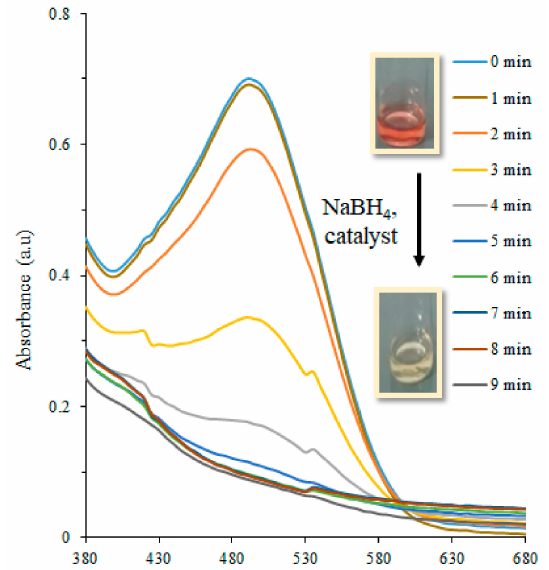
Figure 7. CR reduction in the presence of biosynthesized CAg-nPs catalyst ([CR] = 0.060 mM, [NaBH 4 ] = 7.88 mM, catalyst = 1.8 mg / mL) at ambient